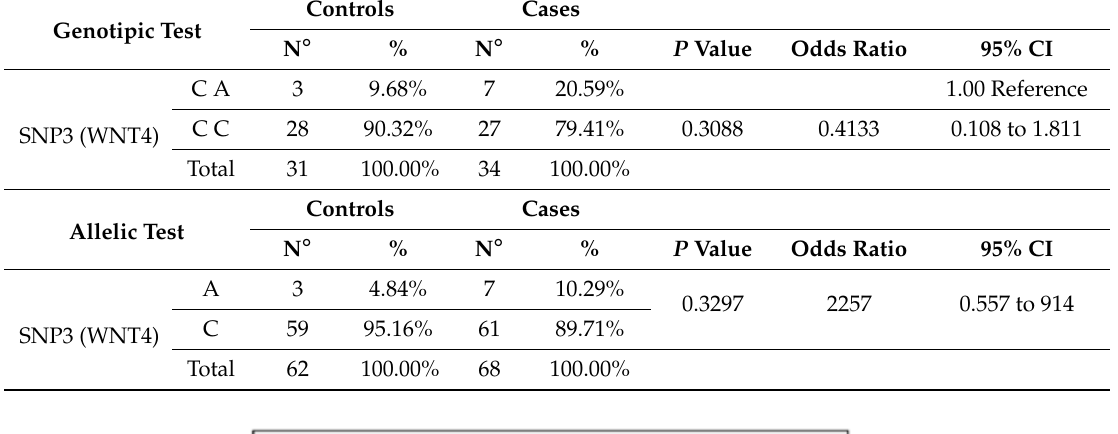
Table 7. Genotypic and allelic frequencies of rs7521902 (WNT4).